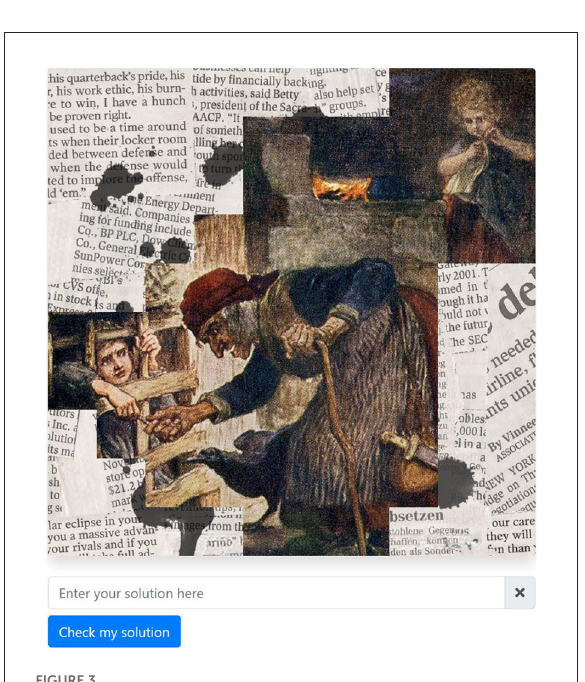
FIGURE3 Example of the Picture Quiz , a game element where students have to uncover the script of a central scene before